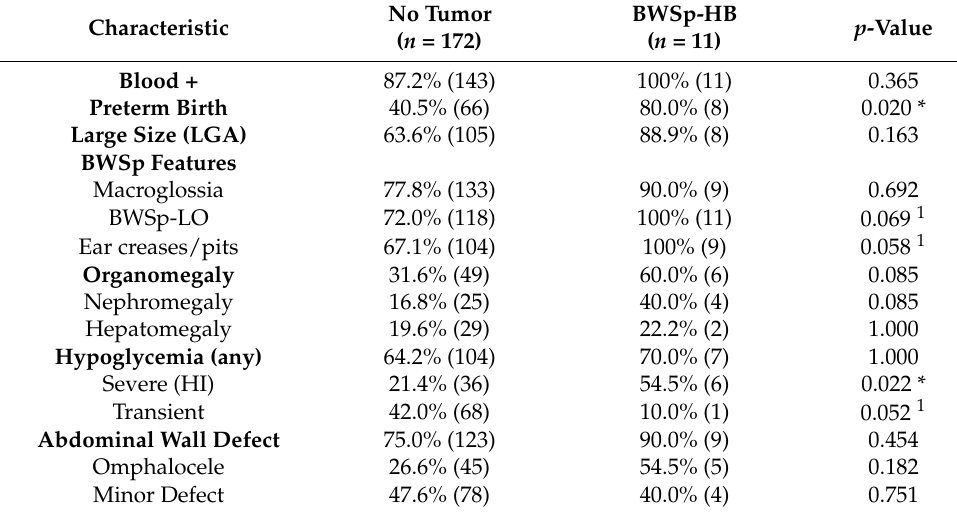
Table 9. Hepatoblastoma (HB)-associated phenotypes within BWSp